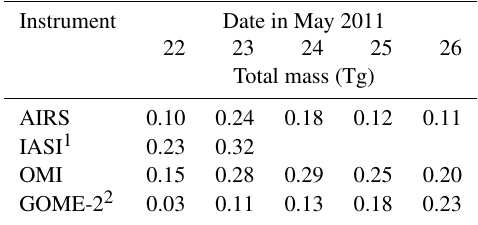
Table 2. SO 2 total mass estimates from four different satellite in- struments (two infrared and two ultraviolet) from 22 to 26 May